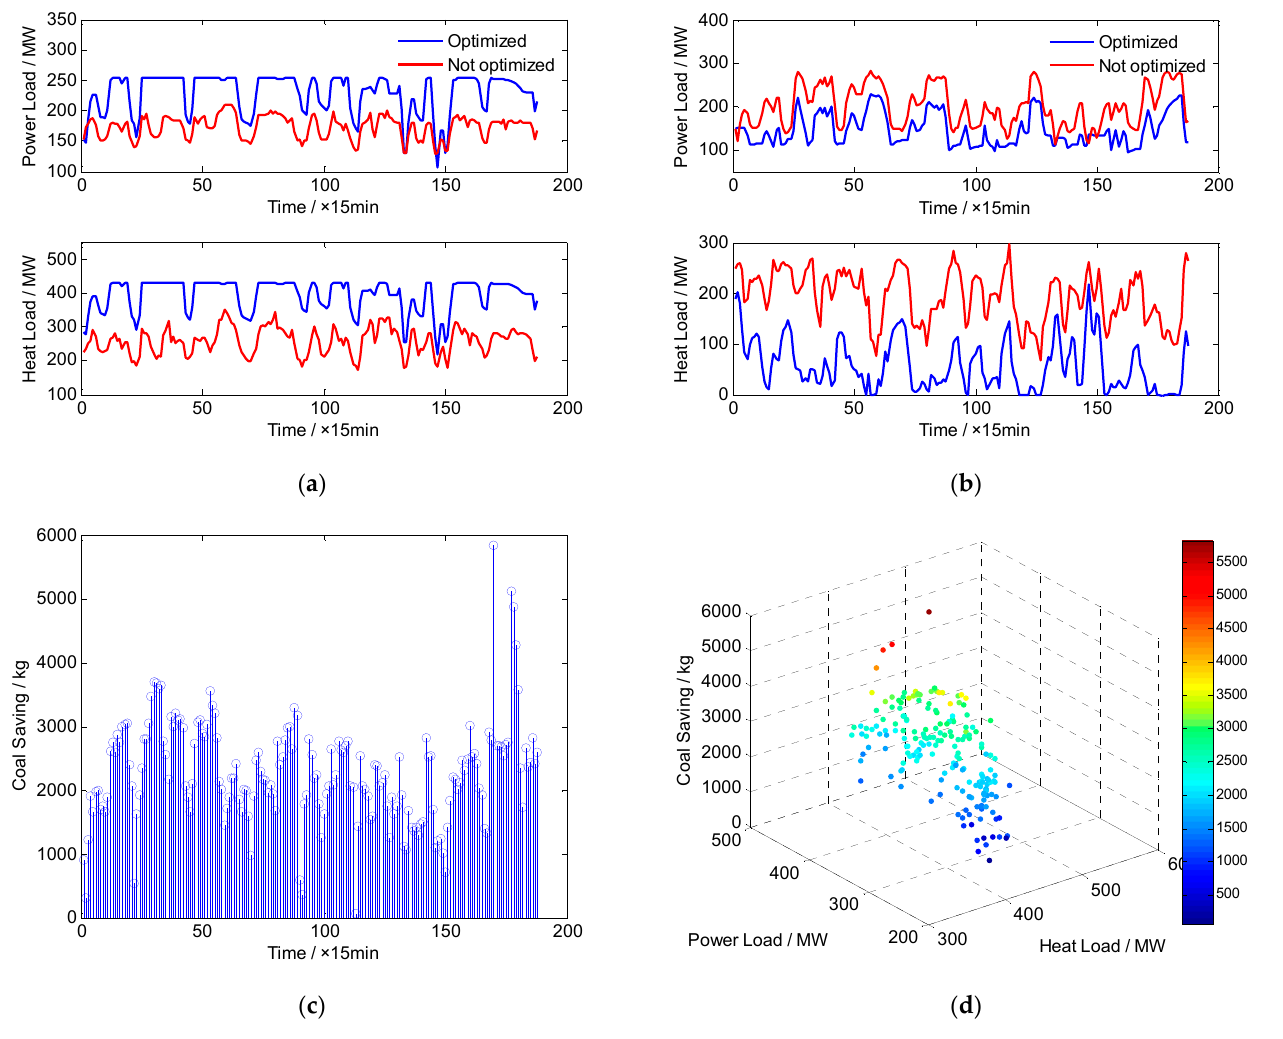
Figure 9. Comparison before and after optimization under mode two (HBP + LPCC + EB) working conditions. ( a ) Electric and heat load of HBP unit. ( b ) Electric and heat load of EH unit. ( c ) Electric boiler load. ( d ) Coal saving before and after optimization. ( e ) Spatial distribution of cost saving po- tential.